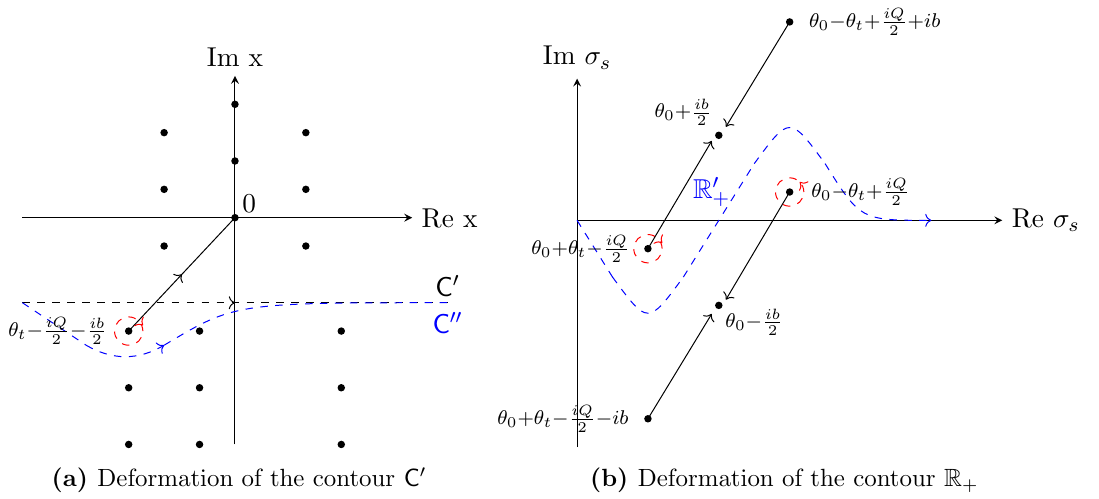
(b) Deformation of the contour R + Figure 2. Schematic illustration of the deformations of the contours C 0 and R +